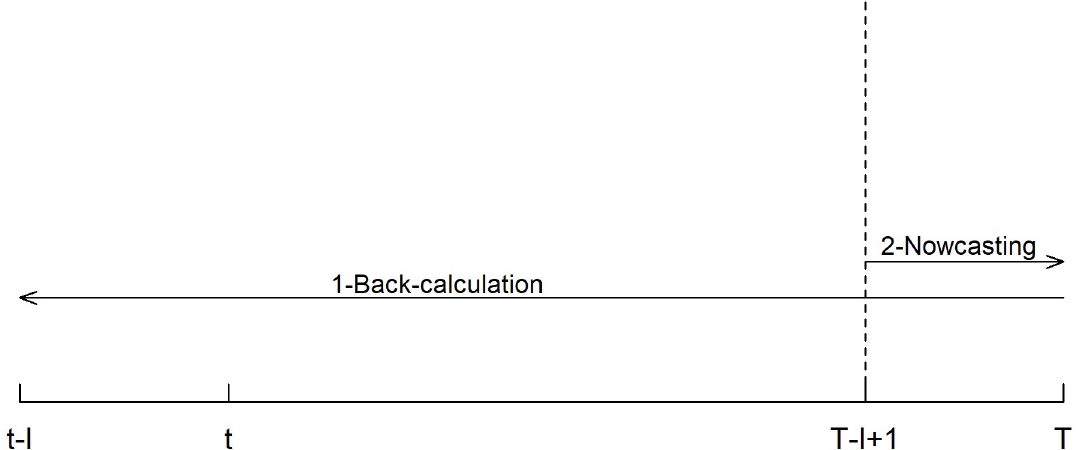
Fig 1. Illustration of back-calculation and nowcasting. Assuming t and T are the first and last reporting day in a line-list data, one needs to first back-calculate the daily case counts that cover the period from day t − l to day T based on reporting delays, where l is the maximum reporting delay. The next step is nowcasting, which is to upscale the back-calculated counts for the period from day T − l + 1 to day T .